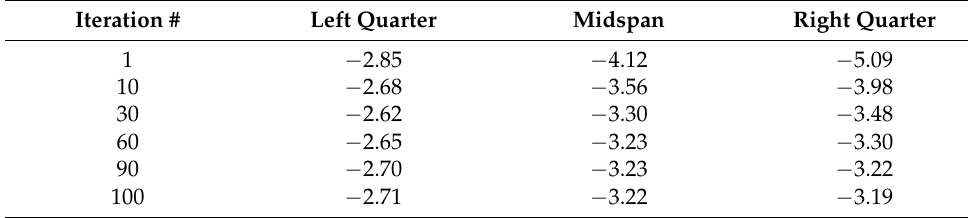
Table 8. Progression of GPA-ICP algorithm.